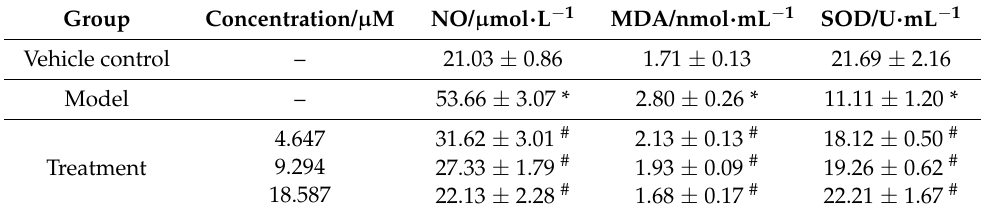
Table 1. The protection of amentoflavone on injury of HUVECs induced by LPS ( n = 5, x ± s